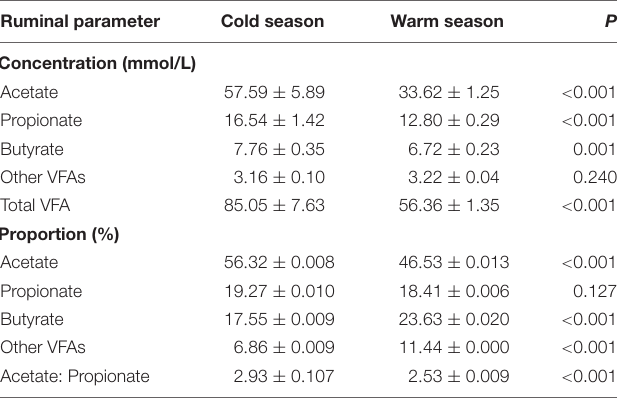
TABLE 1 | Effects of cold season nutritional stress on rumen fermentation